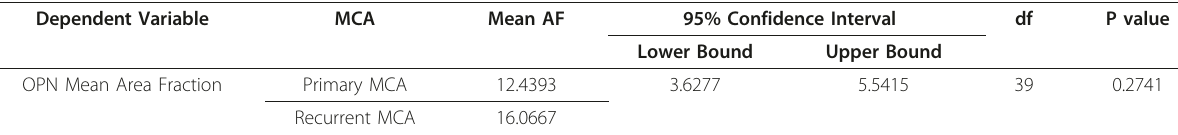
Table 4 Welch Two Sample t-test (OPN) Dependent